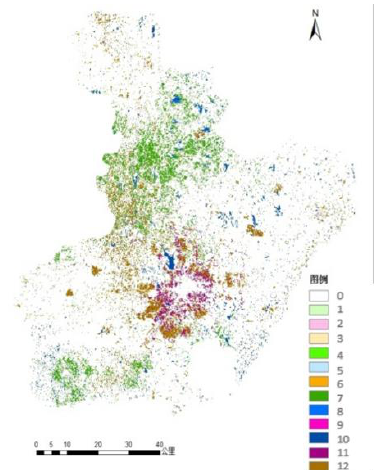
Figure 8 Multi-class change map of post classification comparison method from the year 2000 to 2008